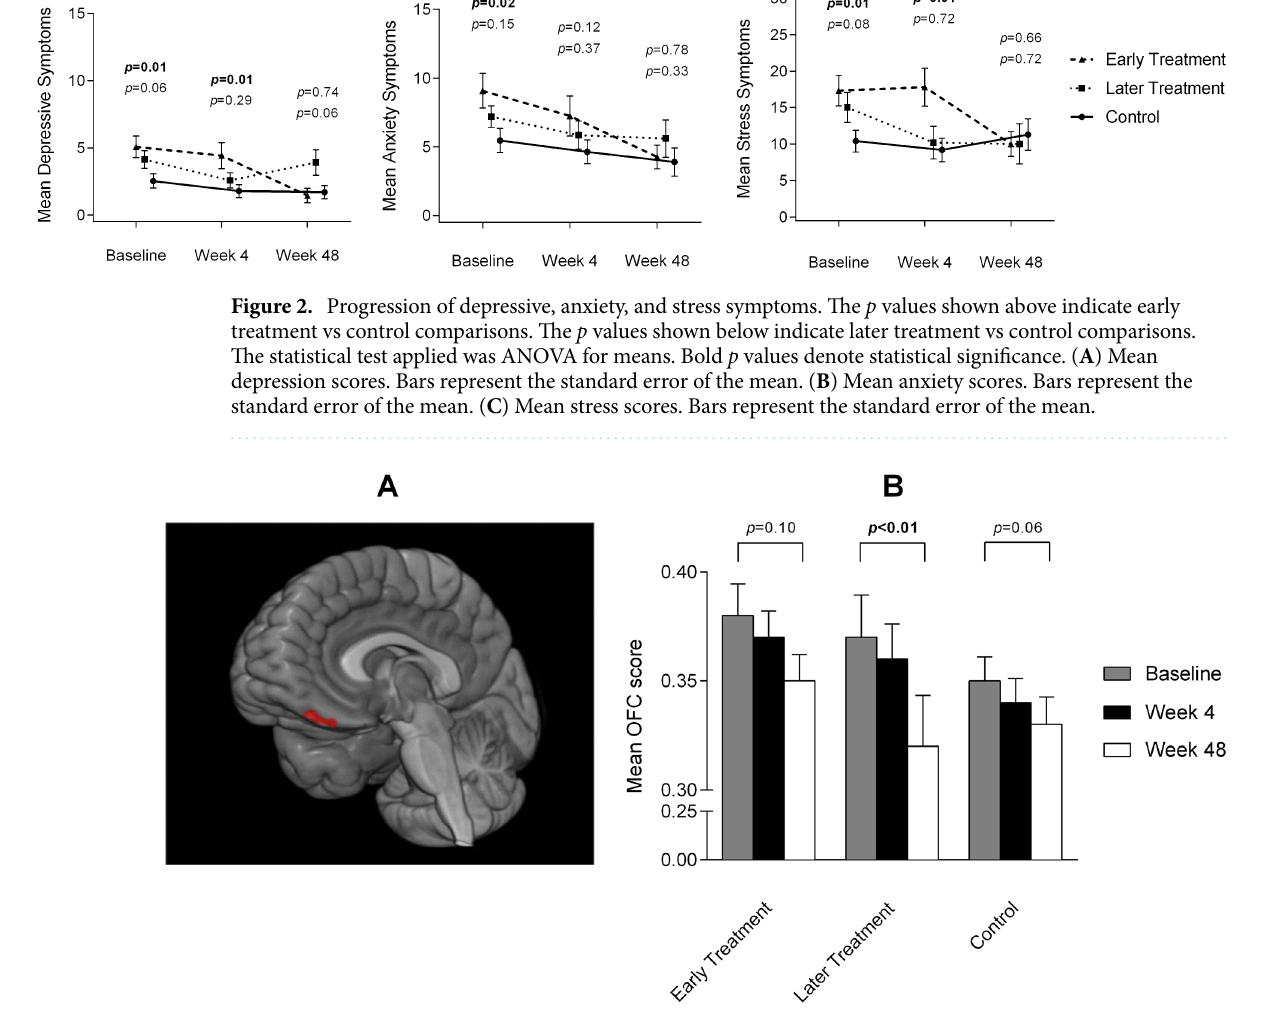
Figure 3. Medial orbitofrontal cortex and mean volume values. ( A ) Voxels showing a significantly larger decrease in gray matter volume at week 4 in relation to baseline in the later treatment arm than in the early treatment arm. These voxels were located at the medial orbitofrontal cortex, with the most significant finding (peak coordinate) at x = 6; y = 44; z = –32 (T = 4.46; p (FWE) = 0.030). ( B ) Mean medial orbitofrontal cortex scores found prospectively. Upper bars represent the standard error of the mean. The Y axis is disproportionate to provide a more optimal presentation of outcomes. The statistical test applied was the longitudinal ANOVA for repeated measures. Bold p value denotes statistical significance. Abbreviations: OFC = orbitofrontal